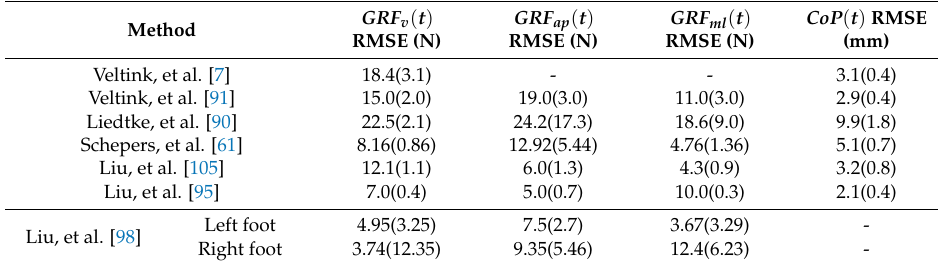
Table 3. Comparison of the RMSE mean (standard deviation) in estimation of tri-axial (cid:1833)(cid:1844)(cid:1832)((cid:1872)) and (cid:1829)(cid:1867)(cid:1842)((cid:1872)) signals using methods suggested by Veltink, et al. [81], Veltink, et al. [82], Liedtke, et al. [80],